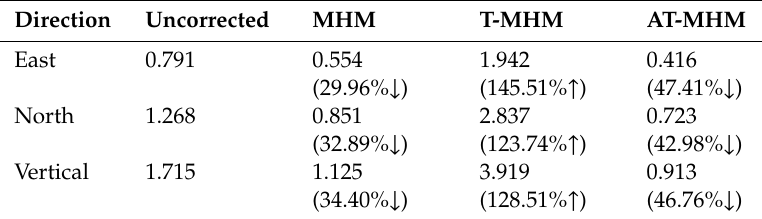
Table 7. The RMSE of the uncorrected and the MHM, T-MHM, and AT-MHM corrected solutions on DOY52. (Unit: